Question: Identify the chart type used in this figure.
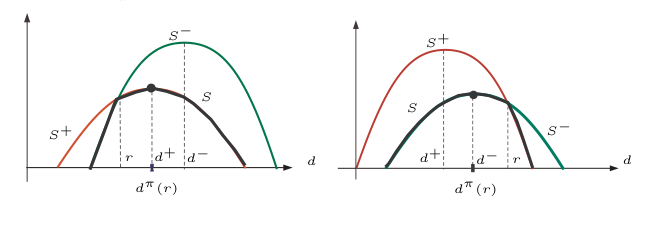
Answer: line